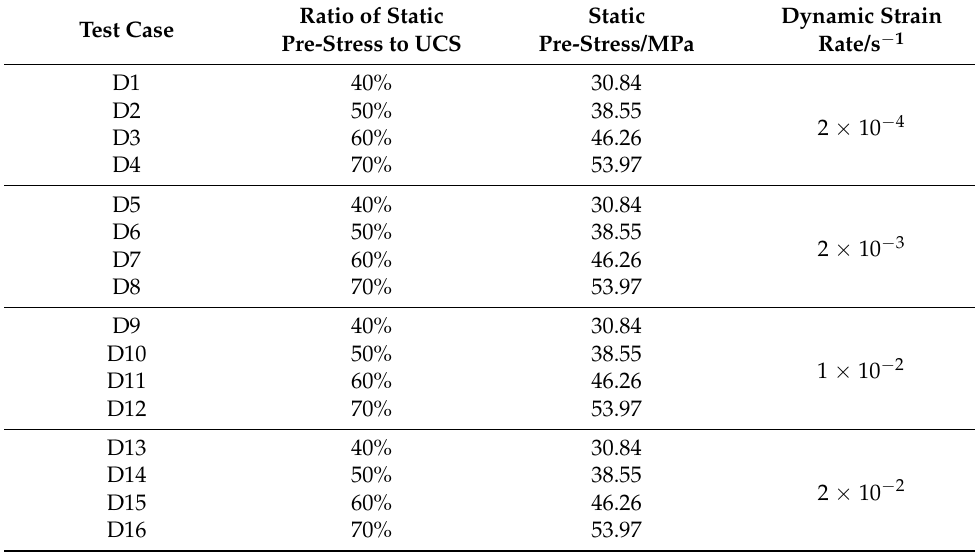
Table 2. Loading